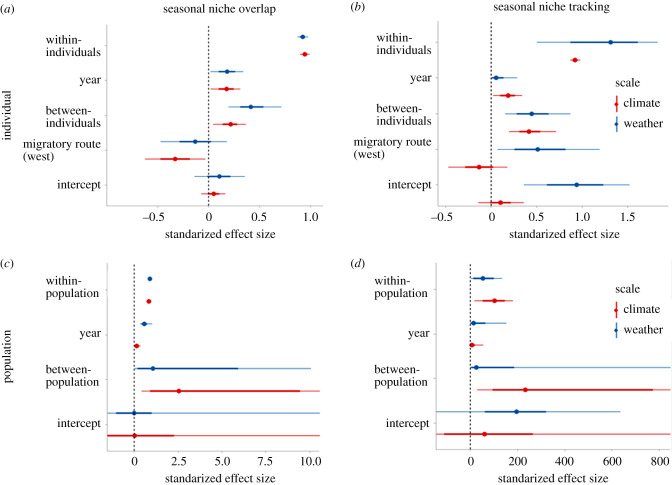
Variation in seasonal niche overlap and niche tracking variability estimation. Standardized coefficients from MCMC generalized linear mixed models of the niche overlap (a,c) and seasonal niche tracking (b,d) at the individual level (a,b) and population level (c,d) for weather and climate, respectively. Points indicate the mean coefficients, thick bars indicate the posterior standard deviations and the thin lines the 95% credible intervals of the coefficient values. Red and blue line colours indicate climate and weather data, respectively. In (b), we divided the standardized effect size by 100 for weather data for a better presentation of the results. The niche overlap and niche tracking were estimated in three-dimensional environmental space with the axes representing temperature, precipitation and NDVI. The reference level for the categorical variable migratory flyway is ‘eastern migrants’. The overlap of the error bars with the dashed line at zero indicates that the effect of the parameter is not statistically significant (i.e. p > 0.05). (Online version in colour.)